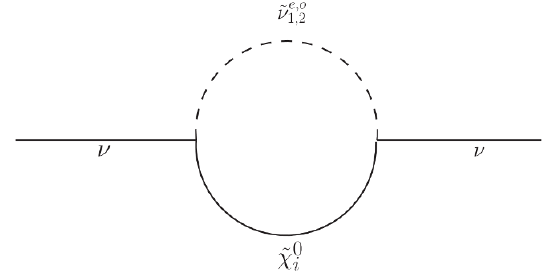
Figure 1 . Schematic diagram showing the leading one-loop contribution to the light neutrino mass. contributions from the loop are proportional to the mass splitting between the CP-even and the CP-odd left-sneutrino state which makes it signi(cid:12)cant in the presence of a rather large T which is responsible for left-right mixing in the sneutrino sector (see eq. (2.6)). These (cid:23) additional contributions to the neutrino mass give signi(cid:12)cant constraints in the f T parameter